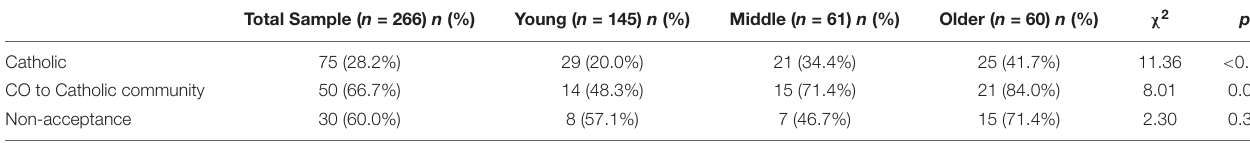
TABLE 4 | Religious variables in young, middle, and older LGBQ+ adults. Total Sample ( n = 266) n (%) Young ( n = 145) n (%) Middle ( n = 61) n (%) Older ( n = 60) n (%) χ 2